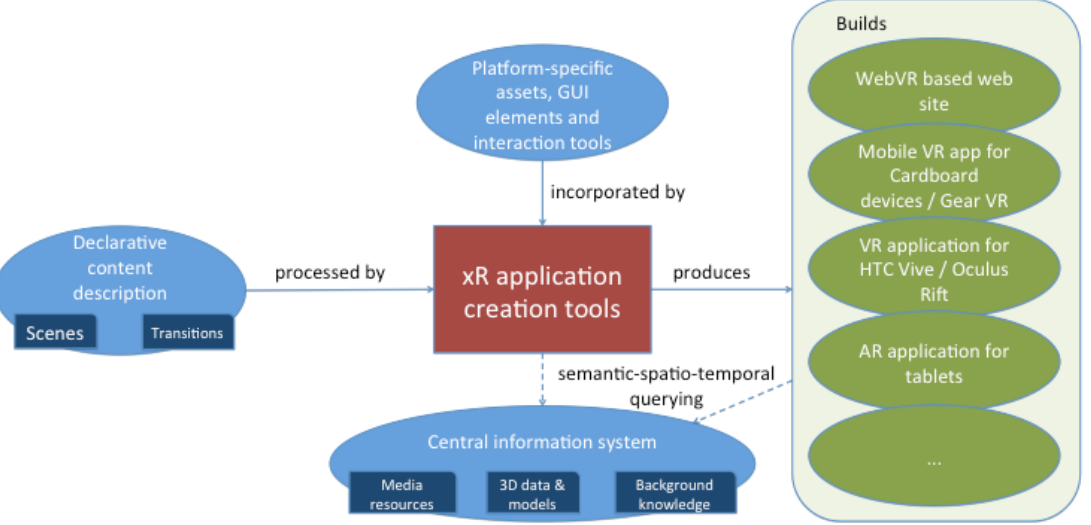
Figure 6. Sketch of our xR application building